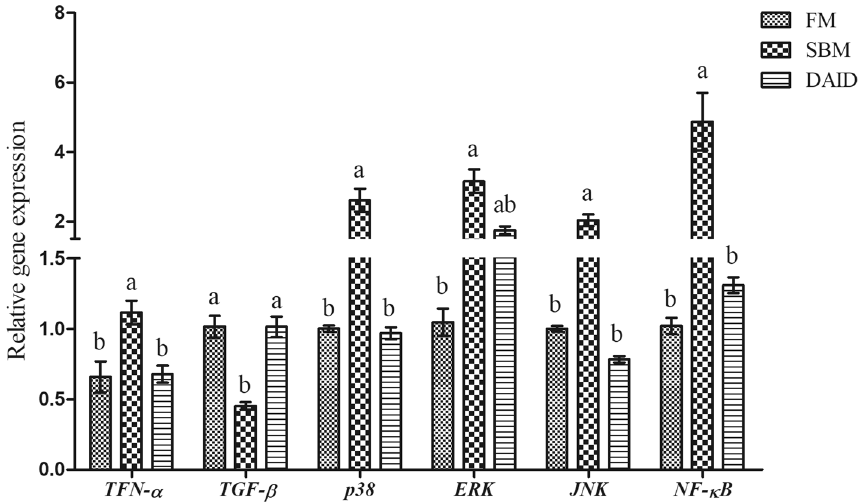
Figure 1. Effects of daidzein on gene expression of cytokines and signaling molecules of turbot fed with soybean meal. FM fish meal diet, SBM soybean meal diet, DAID 40 mg/kg daidzein included into SBM diet, TNF-α tumor necrosis factor-α, p38 p38 mitogen-activated protein kinase, TGF-β transforming growth factor-β, JNK c-Jun N-terminal kinase, ERK extracellular regulated kinase; NF-κB nuclear transcription factor-kappa B; Values are mean ± SEM, n = 3 and values shared different letters are significantly different ( P <